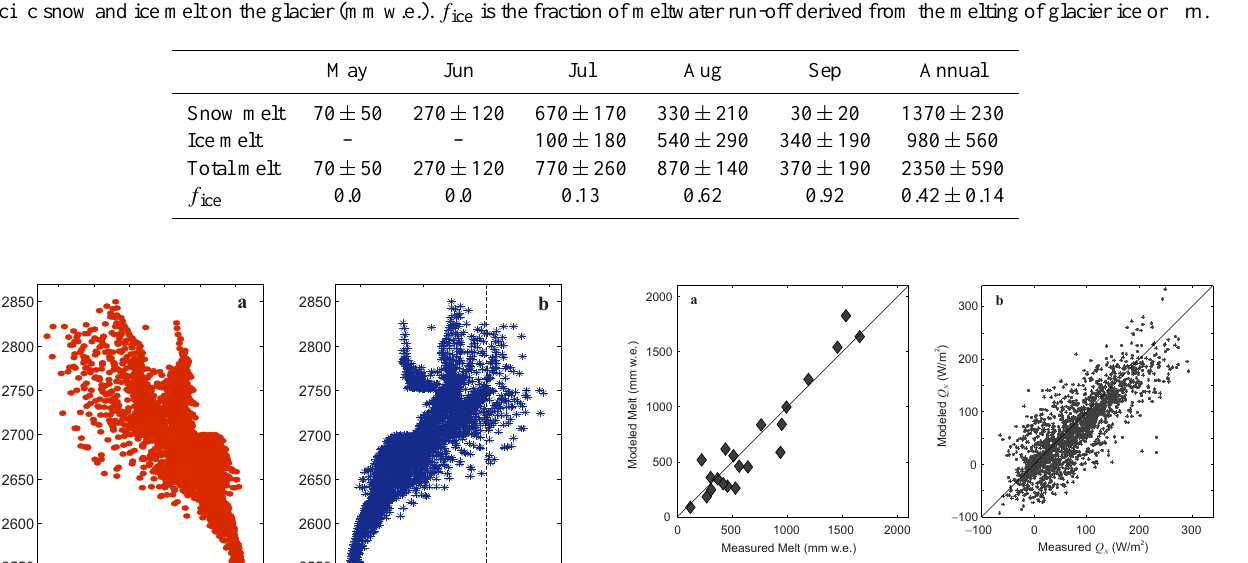
Table 7. Mean ( ± standard deviation) of modelled monthly meltwater run-off at Haig Glacier, 2002–2013, expressed as areally averaged specific snow and ice melt on the glacier (mmw.e.). f ice is the fraction of meltwater run-off derived from the melting of glacier ice or firn.